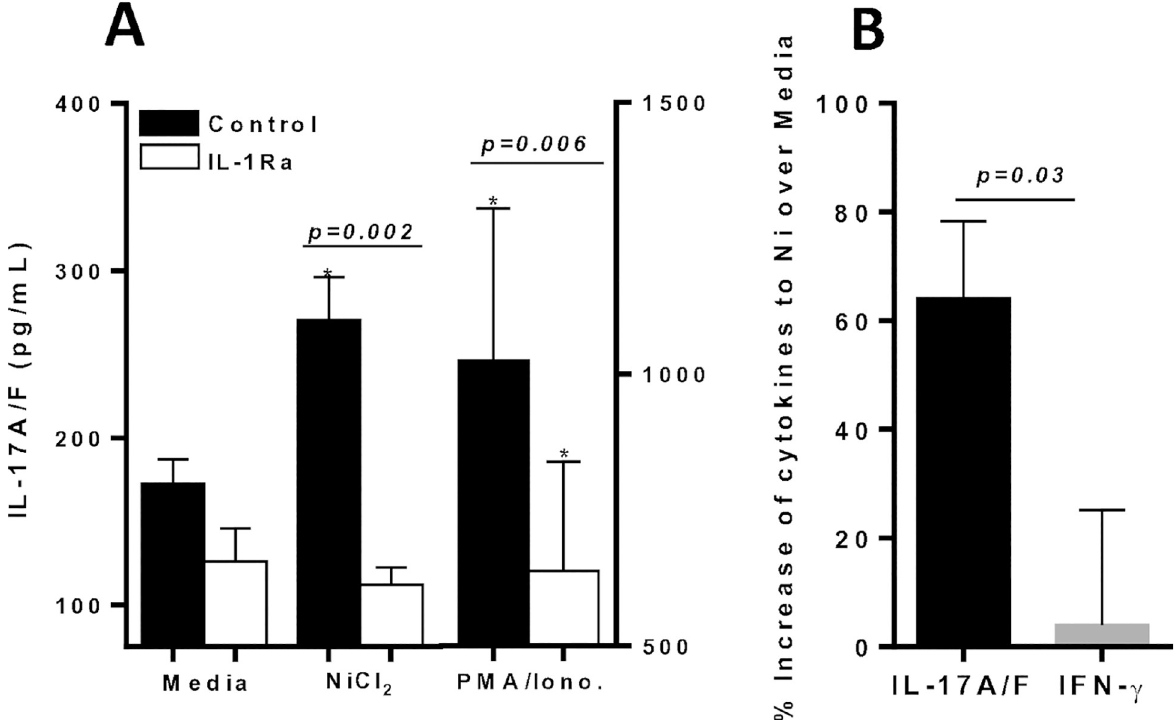
Fig 12. Metal-reactive lymphocytes from individuals’ exhibit significant production of IL-17A/F compared with IFN- γ production to metal challenge. Supernatants were harvested on D 6 and assayed by ELISA for production of (A) IL-17A/F secretion in the absence/presence of metal challenge and/or IL-1Ra from n = 4 metal reactive individuals lymphocytes, and (B) percentage increase of secreted cytokines from n = 4 metal- reactive individuals lymphocytes to Ni challenge over respective control values in the absence of IL-1Ra, demonstrating significant increase in IL- 17A/F production compared to IFN- γ . Data are shown as mean ± SEM. Asterisk ( � ) signifies statistical significance at p � 0.05 compared to respective control group as determined by paired Student’s t-test.